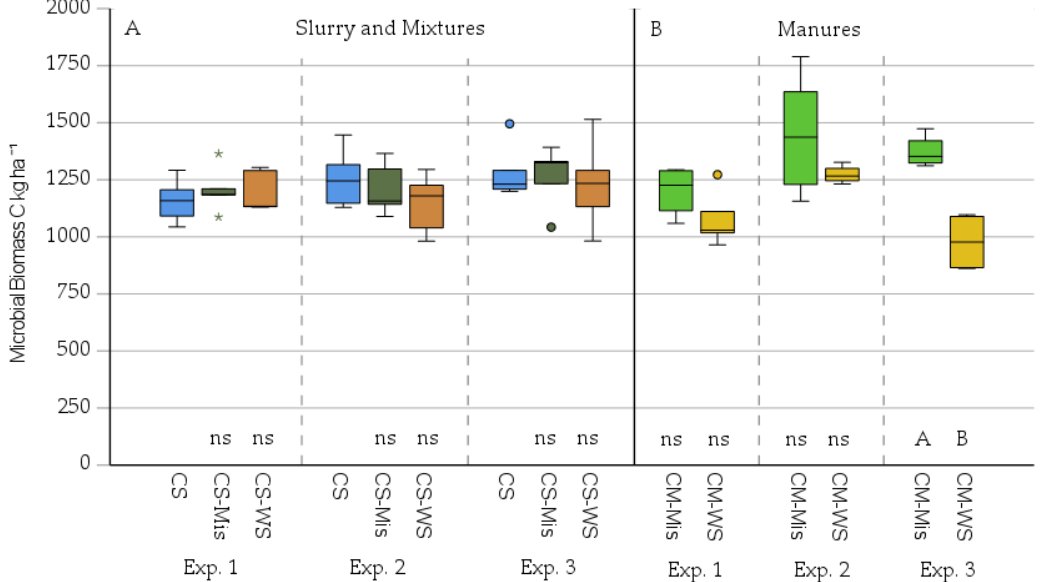
Figure 3. Microbial biomass C kg ha −1 of the soils, applied with different organic fertiliser for experiment 1 (120 kg total N